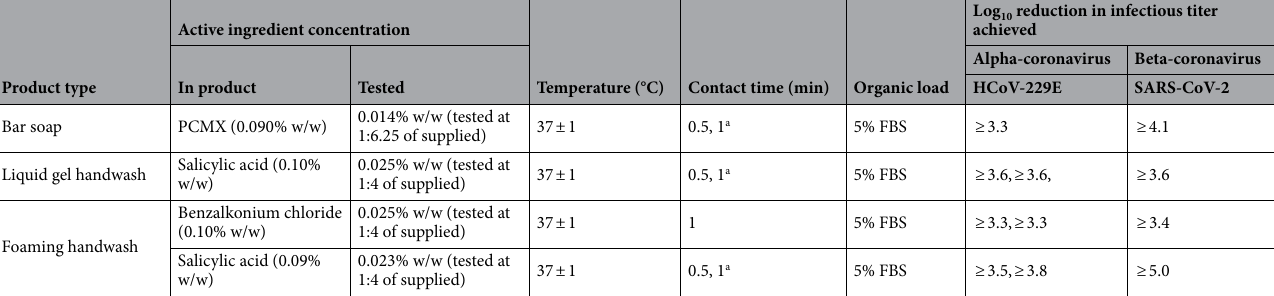
Table 4. Virucidal efficacy of formulated microbicidal actives tested per ASTM-E1052-20 Standard against HCoV-229E or SARS-CoV-2 in suspension inactivation studies. Where multiple cvalues are shown, these represent different technical replicates. Abbreviations used: FBS, fetal bovine serum; HCoV-229E, human coronavirus strain 229E; PCMX, p -chloro- m -xylenol; SARS-CoV-2, severe acute respiratory syndrome coronavirus 2, w/w, weight-to-weight. a A 1-min contact time was used for testing against HCoV-229E; an 0.5- min contact time was used for testing against SARS-CoV-2.